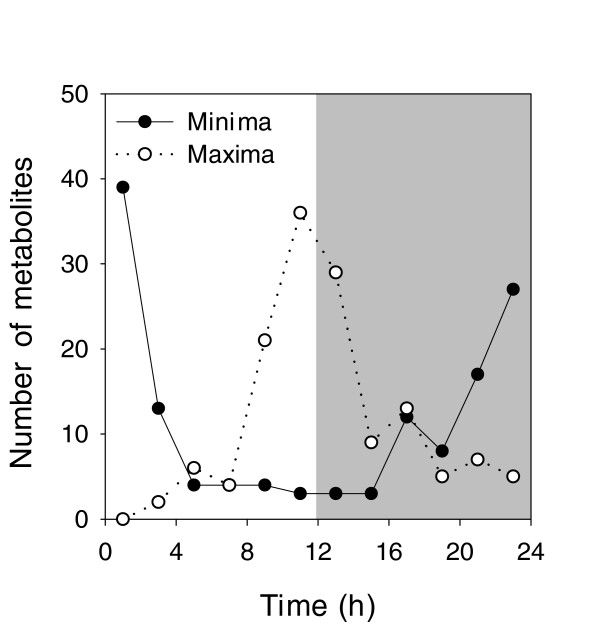
Timing of maxima and minima for metabolites across a 12 h light and 12 h night cycle, in rosettes of Arabidopsis Col0 WT plants. Data were smoothed prior to calculations. The shaded region indicates the dark period.